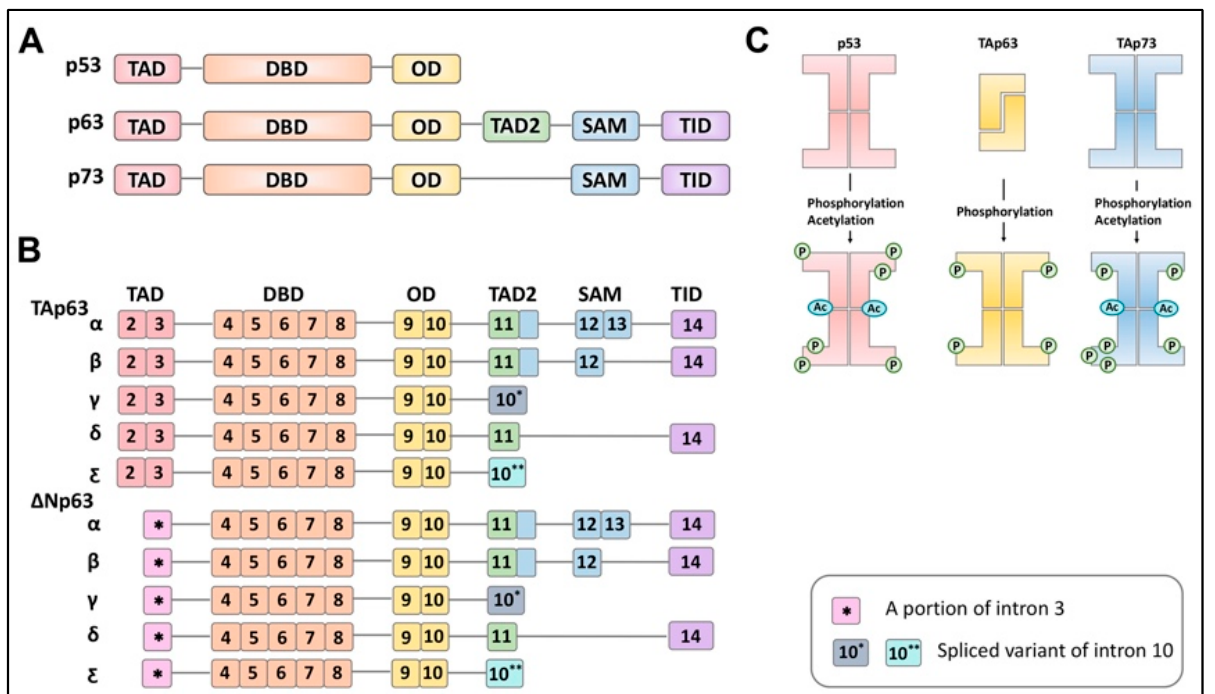
Figure 1. Schematic illustration of the p53, p63, and p73 protein structures and p63 isoforms. ( A ). p53 family protein structures. ( B ). Protein structures of p63 variants. ( C ). Post-translational modification of p53 family proteins. Transactivation domain (TAD), DNA binding domain (DBD), oligomerization domain (OD), sterile alpha motif domain (SAM), and transactivation inhibitory domain (TID).